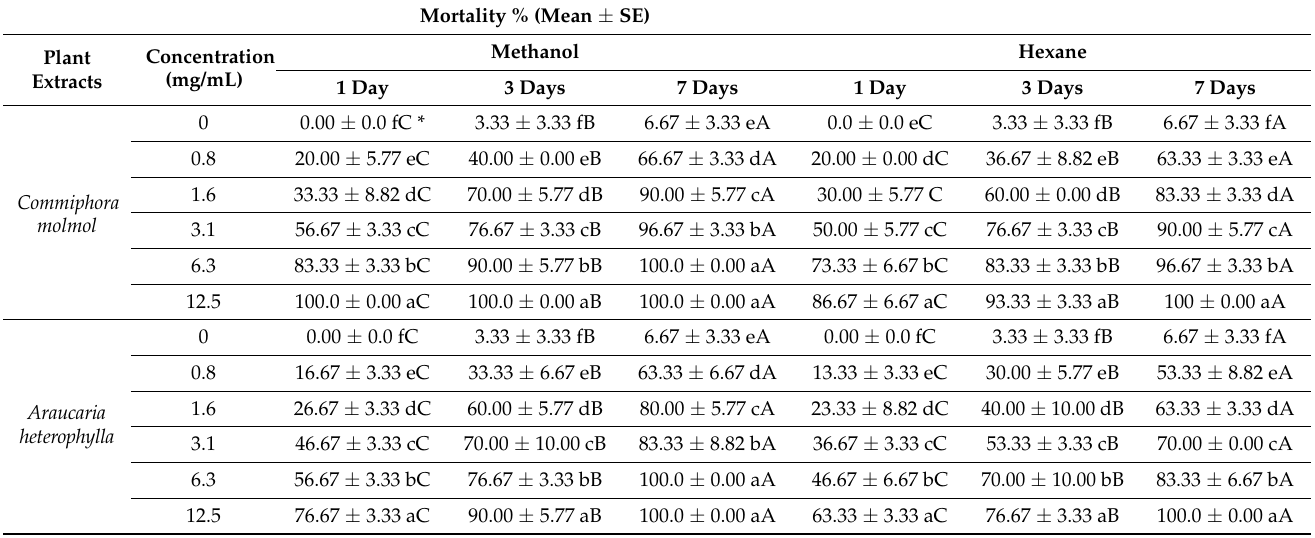
Table 5. Efficacy of the plant extracts of Commiphora molmol and Araucaria heterophylla on cattle lice, Haematopinus eurysternus .